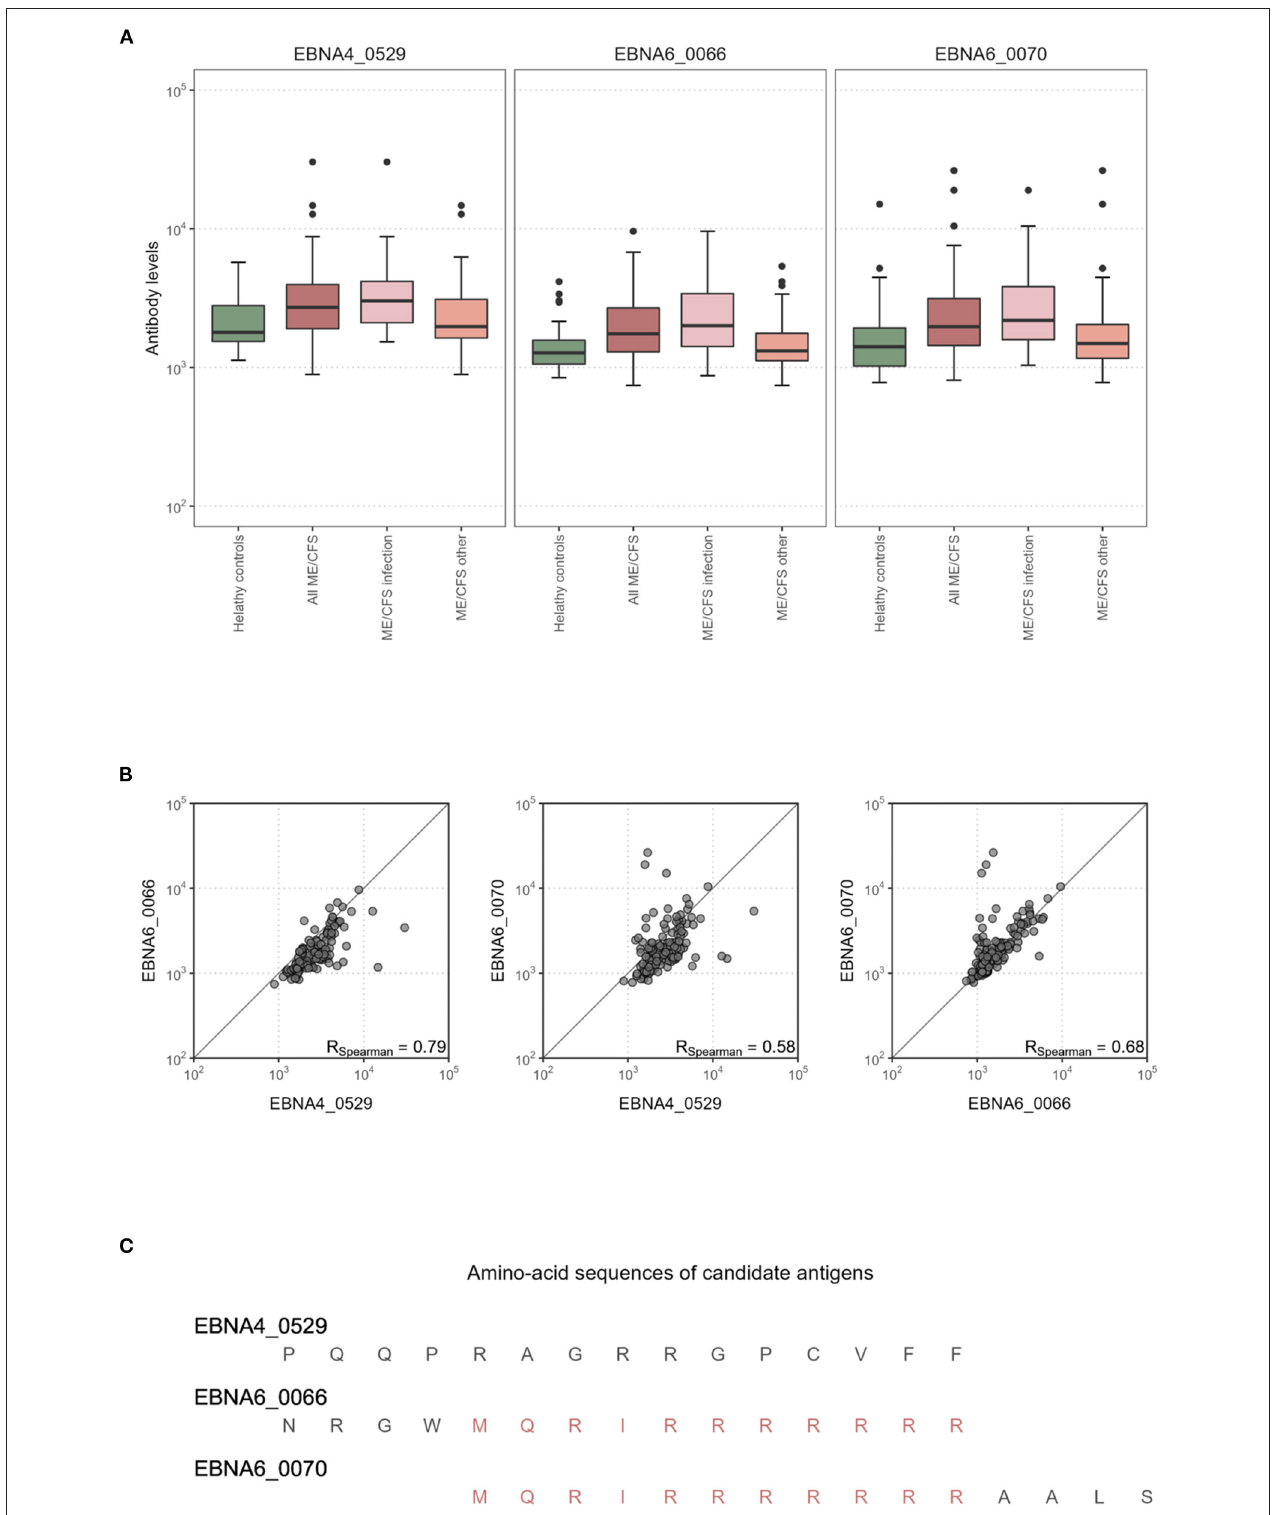
FIGURE 3 | Statistical analysis of the antibody levels related to EBNA4_0529, EBNA6_0066, and EBNA6_0070. (A) Boxplots of the data per study group. (B) Scatterplots and the respectively Spearman’s correlation coefficients (R) in the whole dataset. (C) Amino acid sequences of EBNA4_0529, EBNA6_0066, and